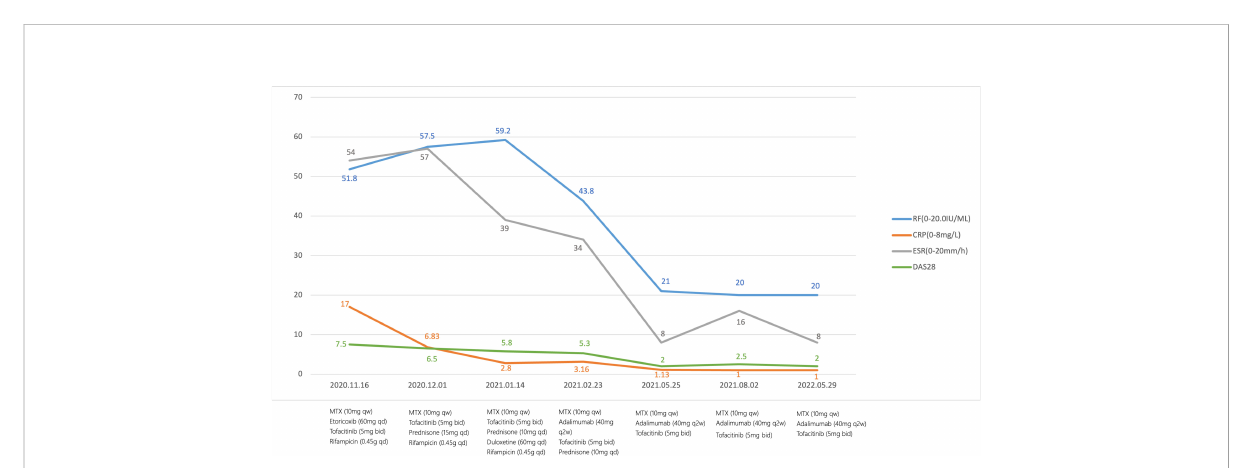
FIGURE 1 Flowchart.The therapeutic timeline of the patient. MTX, methotrexate; RF, rheumatoid factor; CRP, C-reactive protein; ESR, erythrocyte sedimentation rate; DAS28-ESR, Disease Activity Score for 28-joint